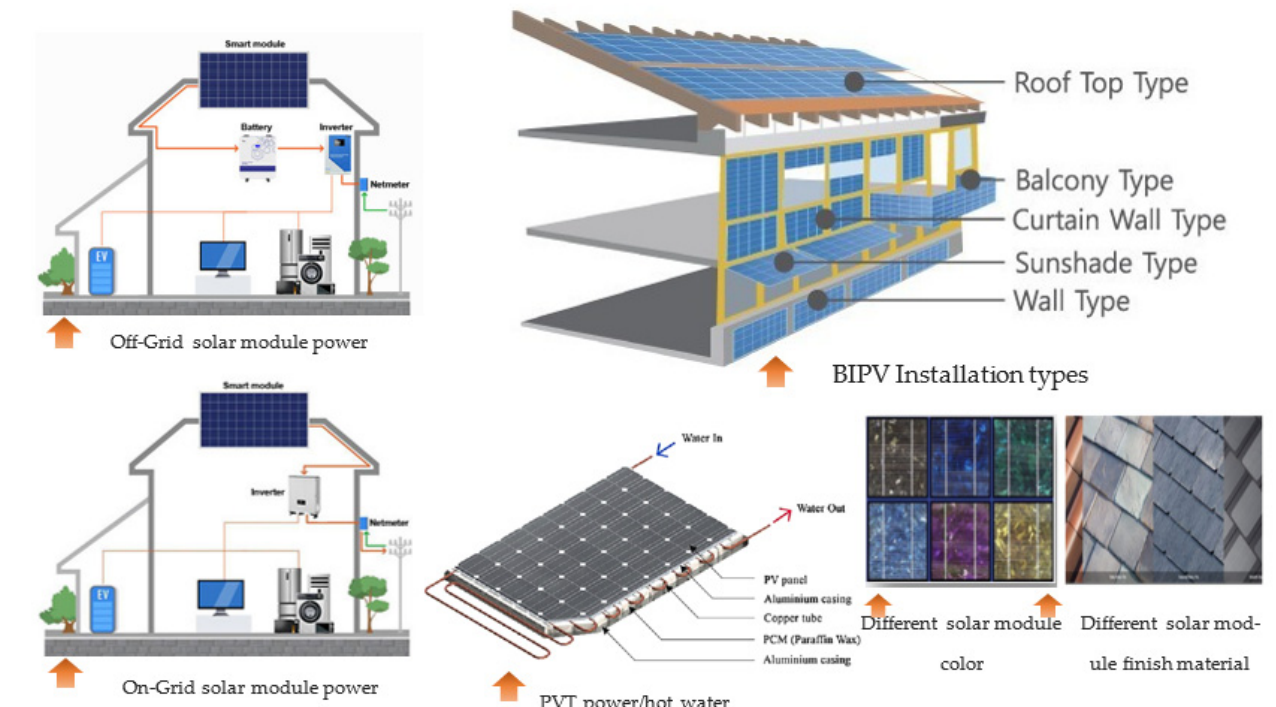
Figure 1. Various solar energy types and technologies for residential